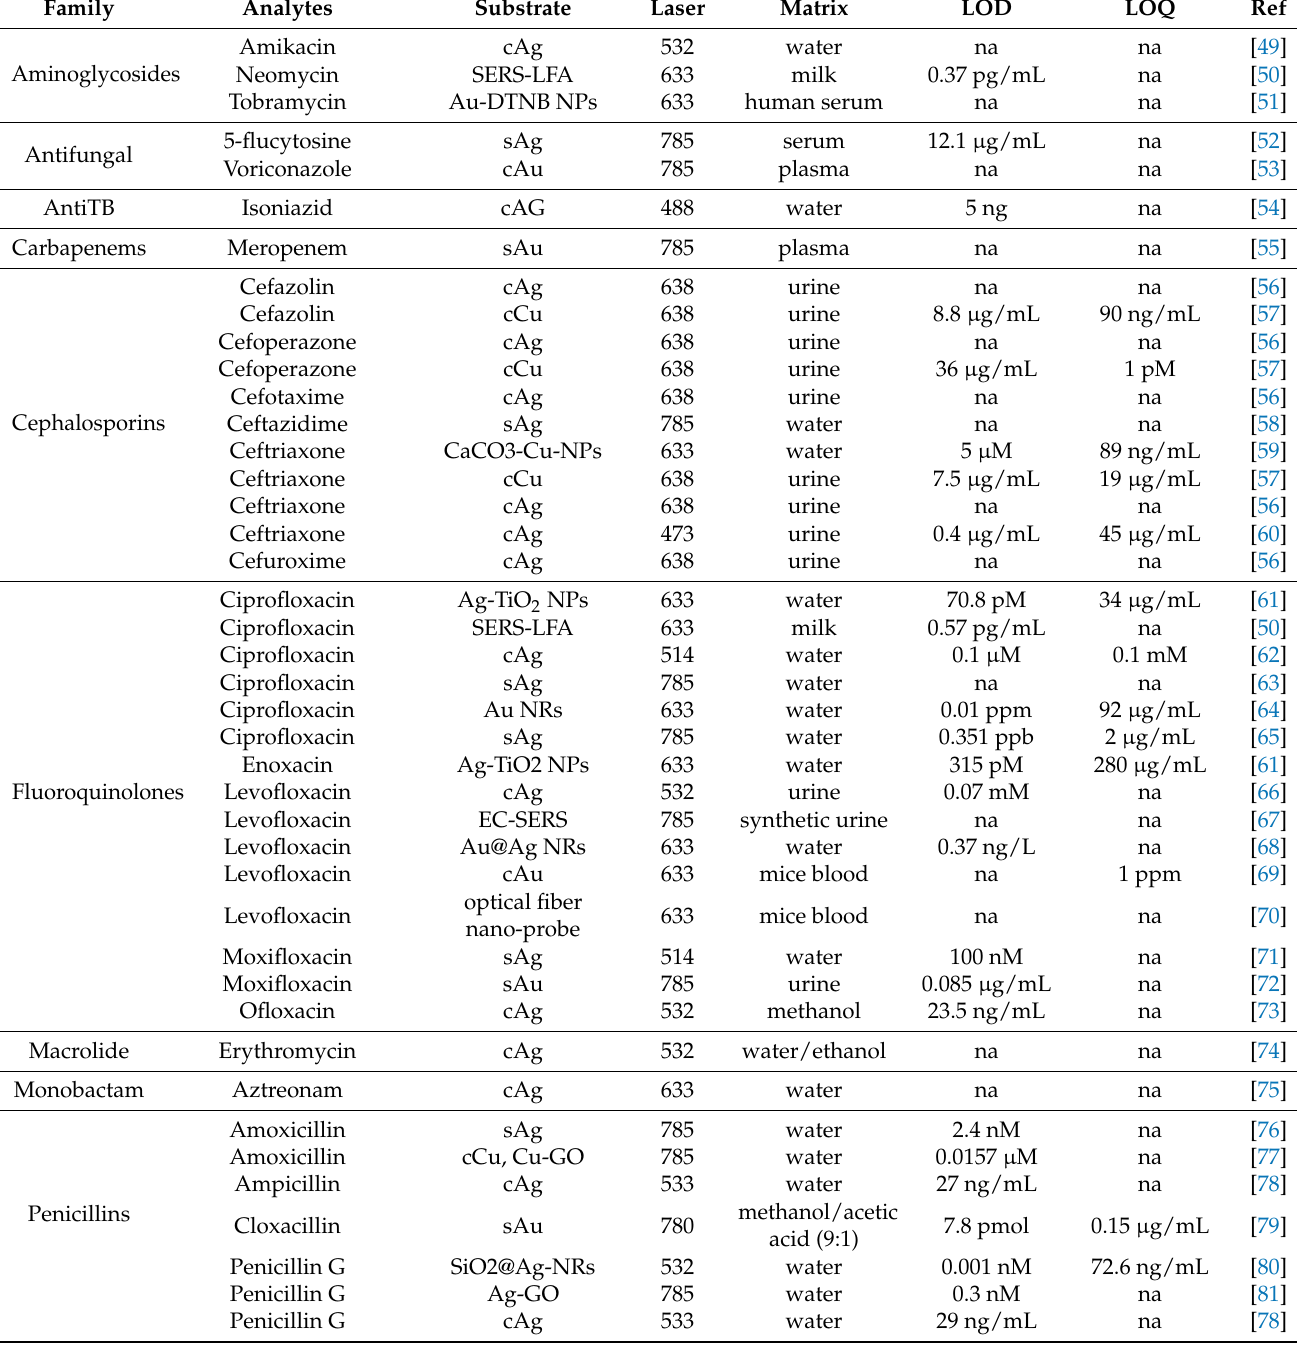
Table 2. A summary of the selected SERS-based application for the detection and quantification of antimicrobial agents in different